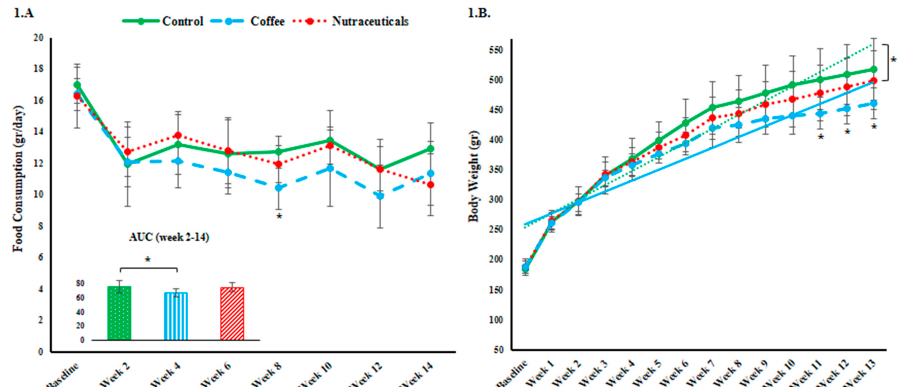
Figure 1. ( A ) The mean daily food consumption measured biweekly and the total food consumed between weeks 2 and 14 (as the area under the curve). ( B ) The trend of changes in body weight of each group over time is displayed. Straight lines represent the slope of changes in coffee vs. the control group; Error bars represent standard deviation of the mean. Asterisks denote significantly different values from the control group (* p < 0.05).